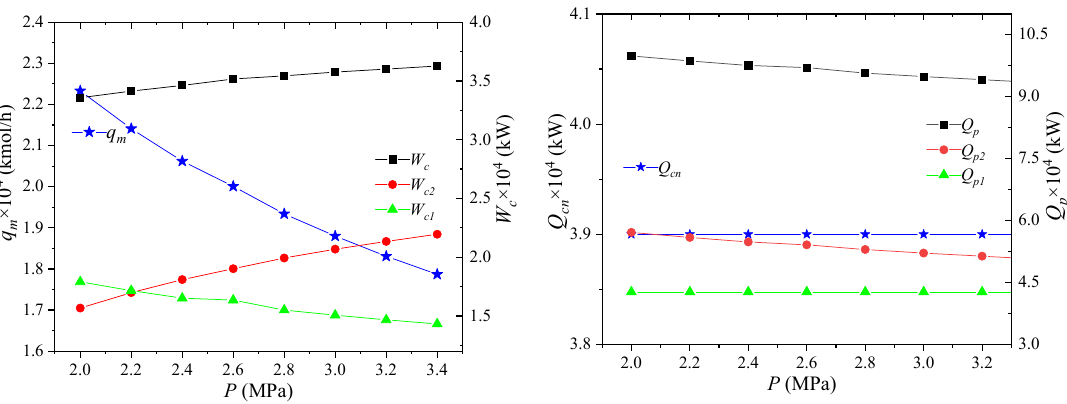
Figure 10. E ff ects of high-pressure mixed refrigerant pressure on process